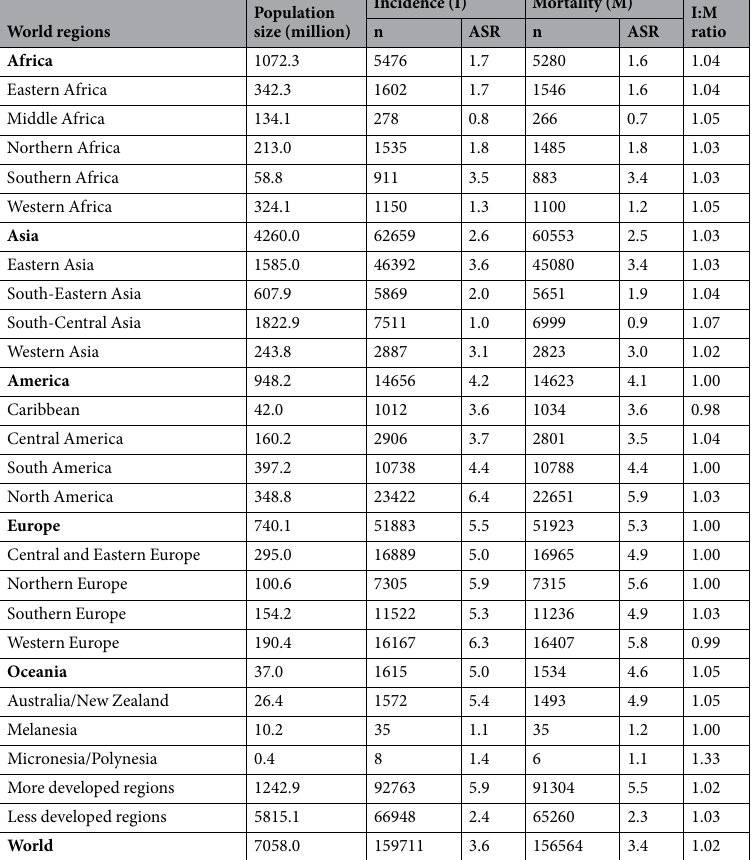
Table 2. The estimated incidence and mortality of pancreatic cancer according to world area, 2012, female. ASR = Age standardized rate per 100,000. Source: GLOBOCAN 2012 [1]. Numbers are rounded to the nearest 10 or 100, and may not add up to the total. The population size of the world regions were retrieved from the Population Reference Bureau, Washington, DC. Available at: http://www.prb.org/Publications/Datasheets/2012/